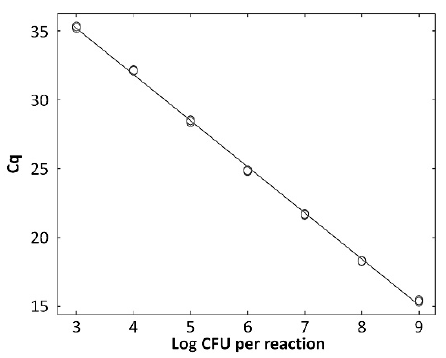
Figure 6. Result for the detection of L. zeae in spiked milk sample. Standard curve generated by plotting Cq values with logarithm of the number of L. zeae strain artificially inoculated per milliliter of milk. Standard curve equation is y = − 3.343 x + 45.215 ( R 2 = 0.999).